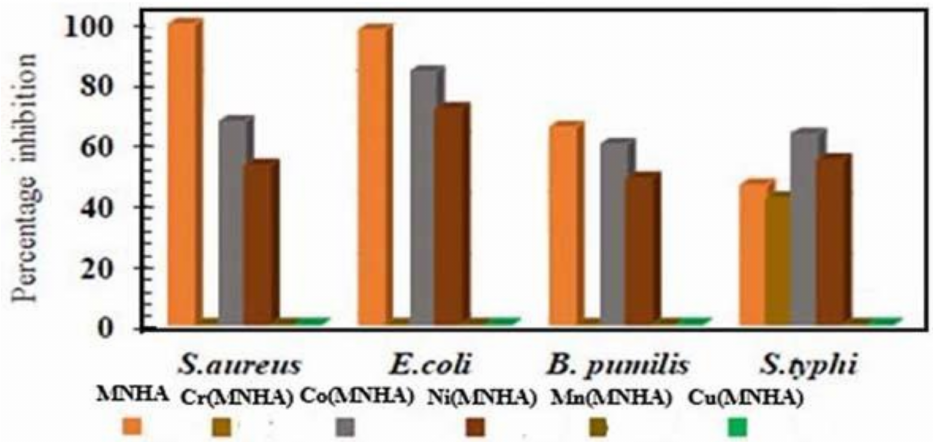
Figure 6. Comparative histograms of compounds 3 – 8 ( S.typhi, E.coli = Gram-negative bacteria and B.subtilis, S.aureus = Gram-positive bacteria) in terms of % inhibition